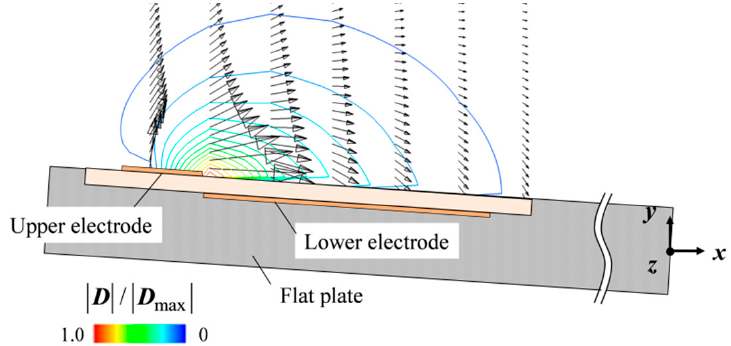
Figure 7. Predicted contours of the amplitude and vectors of the body force by plasma actuator, where the actuator is installed on top surface of the plate.